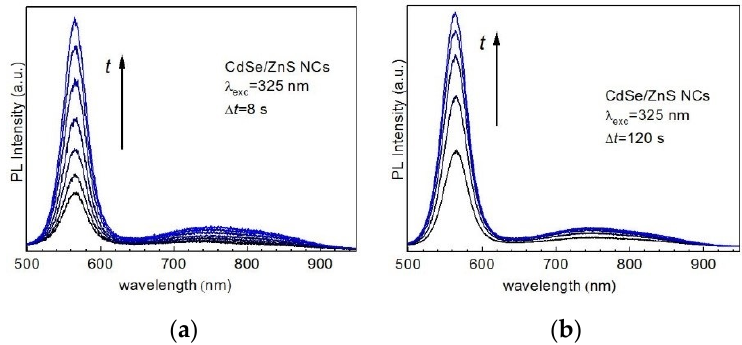
Figure 3. A schematic representing the mechanism proposed in this work to interpret the photoinduced changes (photoenhancement) in the PL spectra of NCs in a polymer matrix. The dotted lines denote non-radiative transitions of the photoexcited carrier to the trap states (trapping). Charge carriers that fill the states and block PL emission from them are depictured in grey. The charge carriers in three other colors denote those available for different recombination mechanisms (indicated by an arrow of the same color): excitonic or near-bandgap PL (EPL, green); defect related PL bands DPL1 (yellow) and DPL2 (red). The evolution of the energy level filling upon NC photoexcitation is as follows: ( a ) initially both radiative and non-radiative traps are empty; ( b ) filling of the non-radiative traps and concomitant increase of an overall PL intensity; ( c ) partial filling of the radiative trap levels underlying DPL2 band leads to blue shift of the whole DPL band; ( d ) complete filling of the DPL2 trap levels and disappearance of DPL2 contribution from the spectrum.